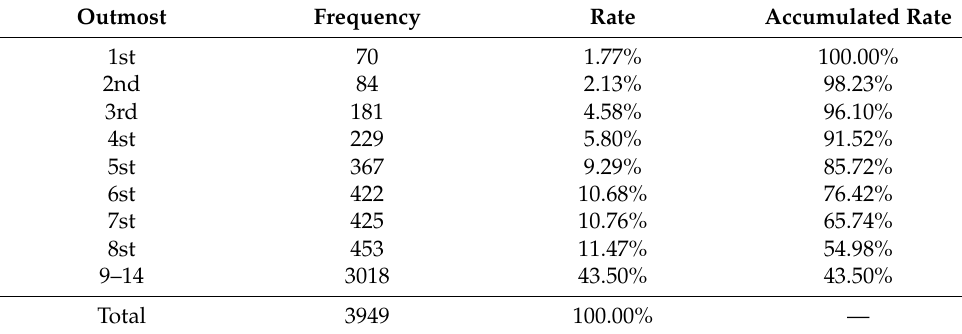
Figure 3. Distribution of one-pixel attacks for each digit. Table 4. Regional distribution of one-pixel